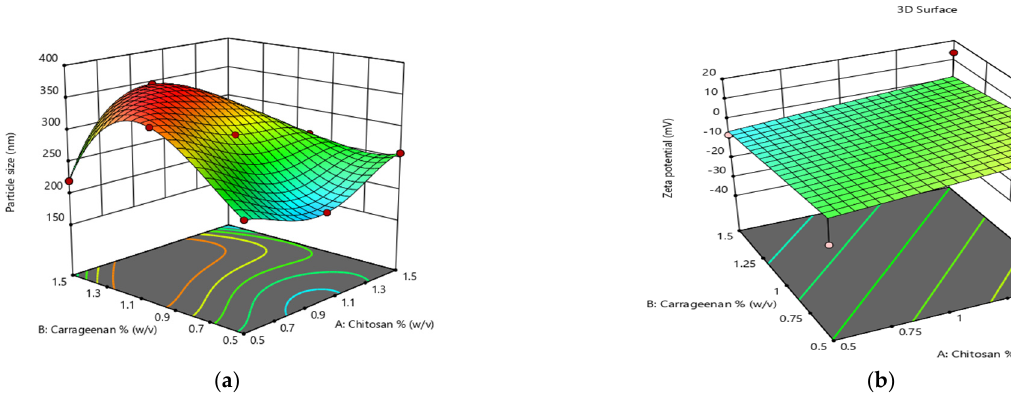
Figure 1. Response surface plot for optimization of chitosan and carrageenan concentration for ( a ) particle size and ( b ) zeta potential by response surface methodology (RSM). Table 1. Experimental runs for optimization of mancozeb-loaded chitosan-carrageenan